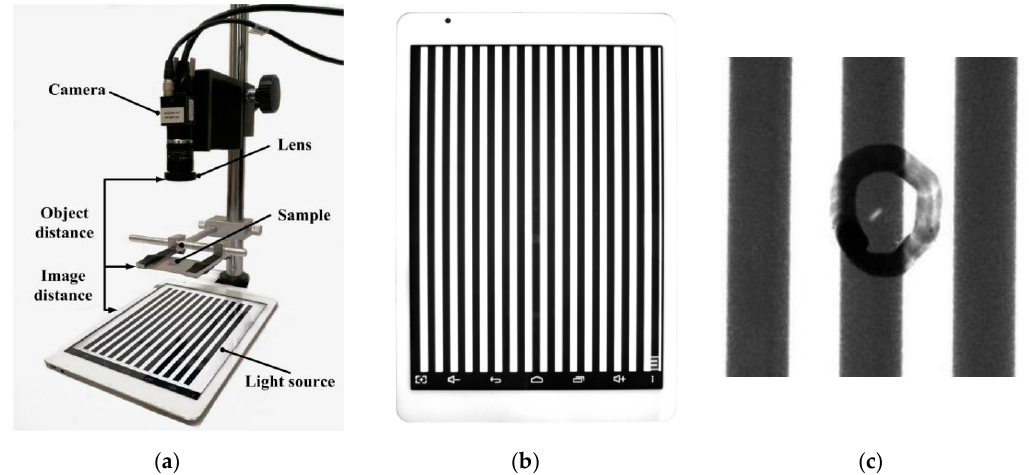
Figure 3. Saturated imaging system platform. ( a ) System setup, ( b ) black and white stripes of structured light, ( c ) example image of a defective area.